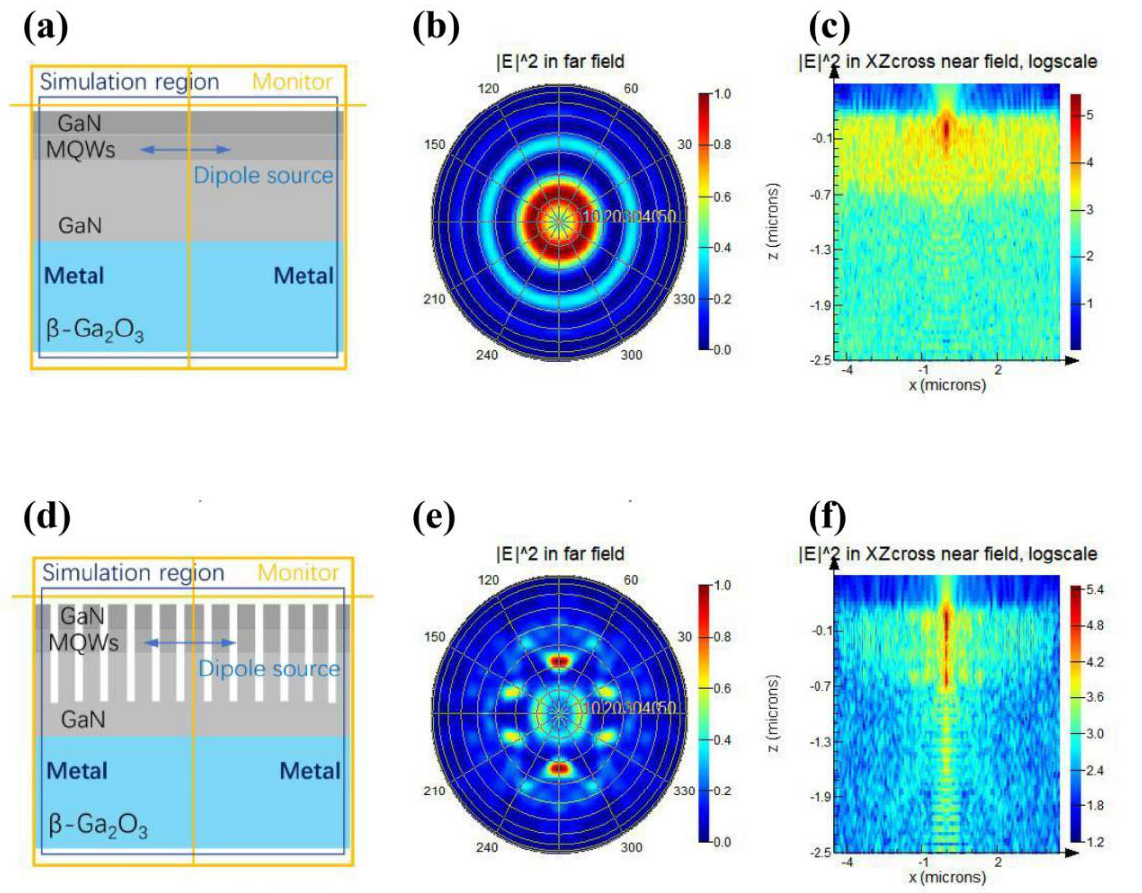
Figure 5. The FDTD simulation of the planar LED on (-201) β -Ga 2 O 3 substrate: ( a ) The simulation structure. ( b ) The far-field distribution of light energy. ( c ) The cross-sectional near-field distribution of light energy at X-Z plane. The FDTD simulation of the nanorod LED on (-201) β -Ga 2 O 3 substrate: ( d ) The simulation structure. ( e ) The far-field distribution of light energy. ( f ) The cross-sectional near-field distribution of light energy at X-Z plane.